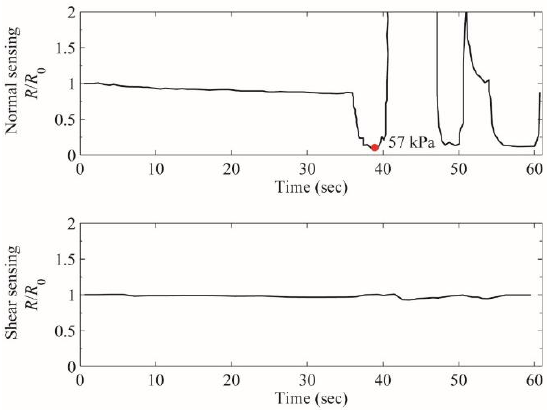
Figure 5. The resistance changes in normal pressure sensing element (top) and shear force sensing element (bottom): upon varying pure external normal force during 35 ~ 60 s, the resistance of normal pressure sensing element changes drastically following the amount of normal pressure applied while there was little disturbance in the resistance of shear force sensing element.